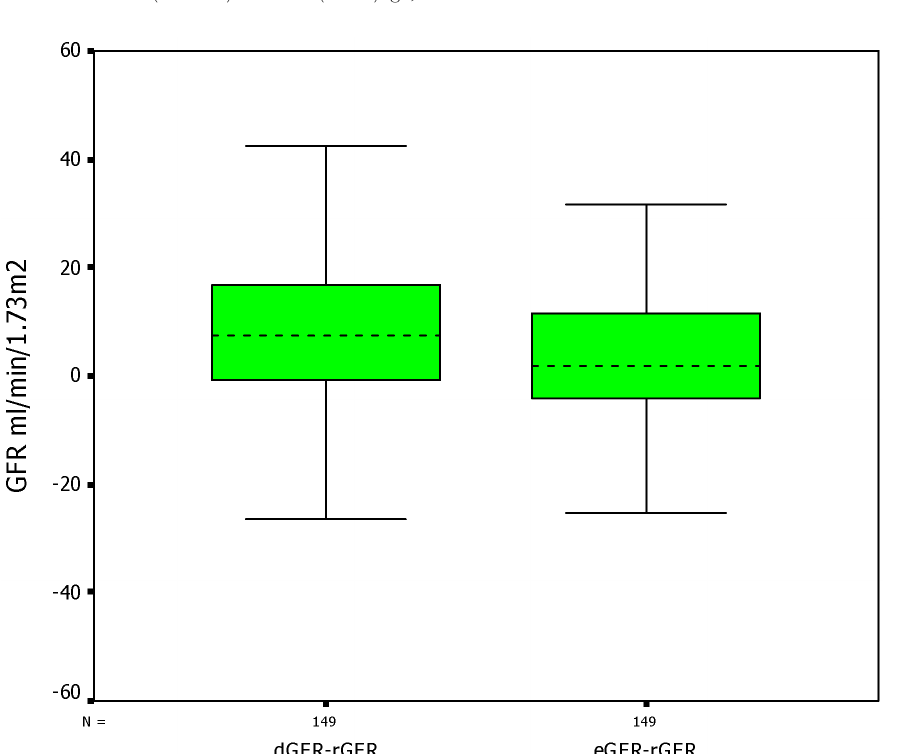
Figure 5. Boxplots of difference in GFRs. The dotted lines indicate the median and the continuous lines represent the quartiles values of difference. Abbreviations: dGFR- the GFR estimated by dynamic renal imaging method, eGFR- the GFR estimated by CDK-EPI equation method, tGFR- the GFR measured by dual plasma sampling method.